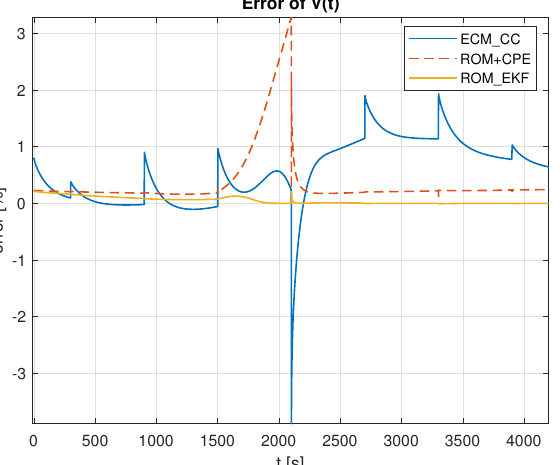
( t ) = [ 0.8,0.2 ] , SOC ∓ 0 NM